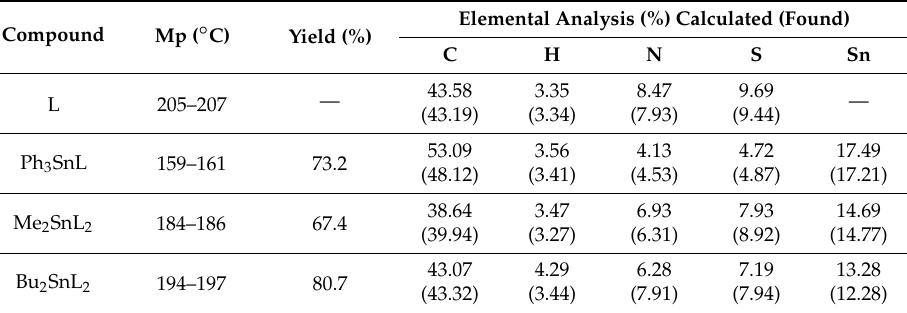
Table 1. Melting points, yields and elemental analyses for L and its Sn(IV) complexes.